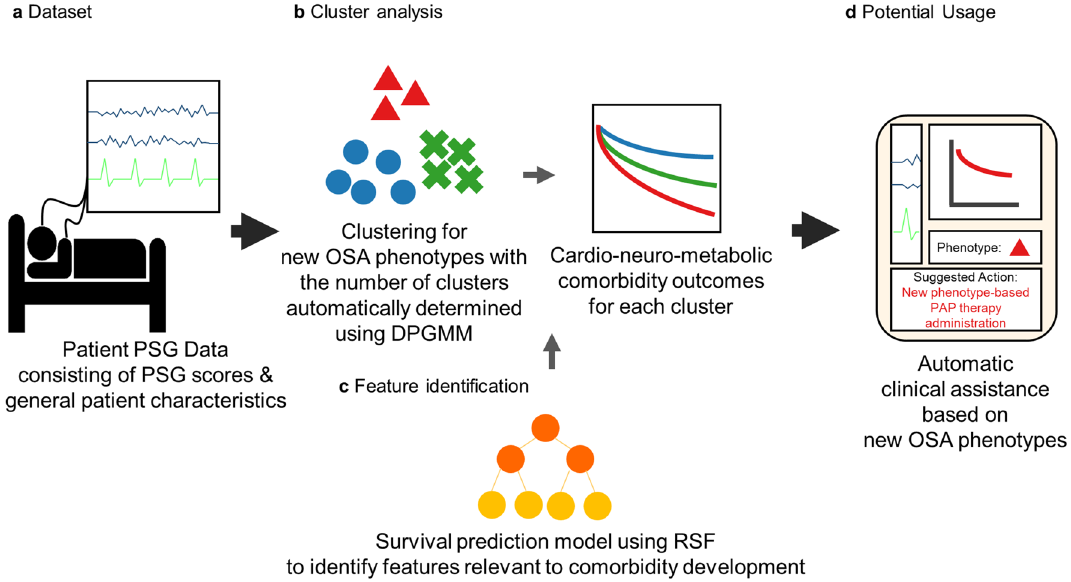
Figure 1. Overall study pipeline. ( a ) The dataset includes PSG scores of the patient cohort. ( b ) OSA patients are clustered based on the PSG data using the DPGMM, which determines the number of clusters automatically during the clustering procedure, and each cluster had different cardio-neuro-metabolic comorbidity outcomes. ( c ) Key cluster features were identified based on features with high importance in predicting comorbidity risks according to the RSF. ( d ) Results can be integrated into the PSG system for automatic clinical assistance, which can improve the diagnosis and treatment of OSA and the associated cardio-neuro-metabolic diseases. PAP, positive airway